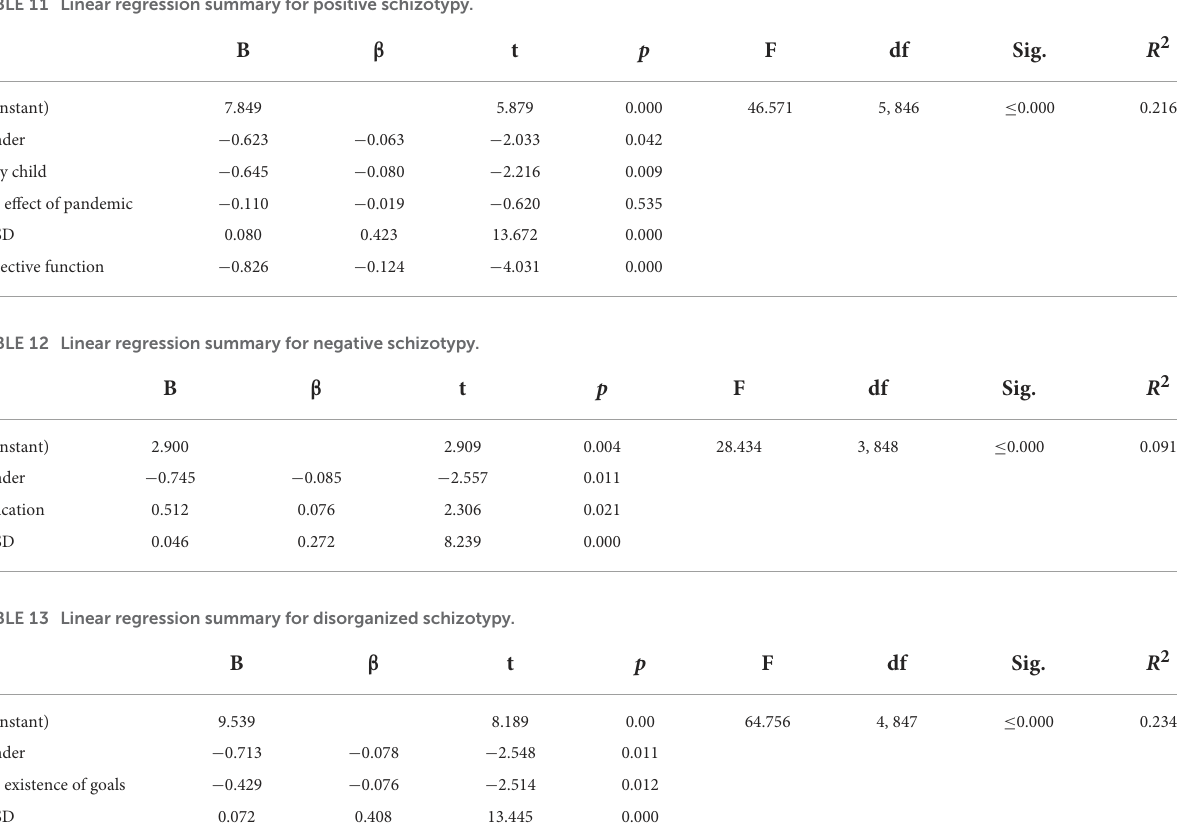
TABLE 11 Linear regression summary for positive schizotypy.